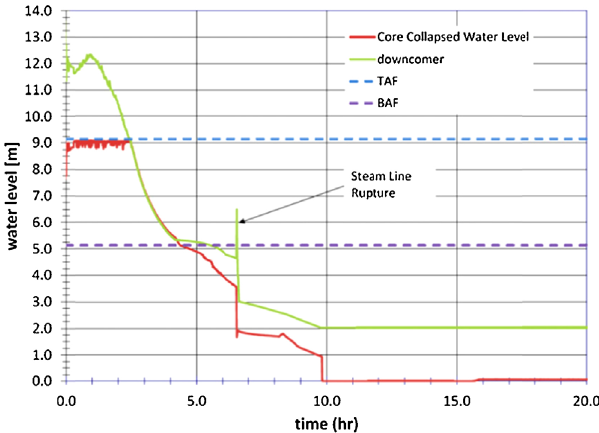
Fig. 1. MELCOR prediction of water level evolution in the reactor core and downcomer regions (Unit 1) [2].